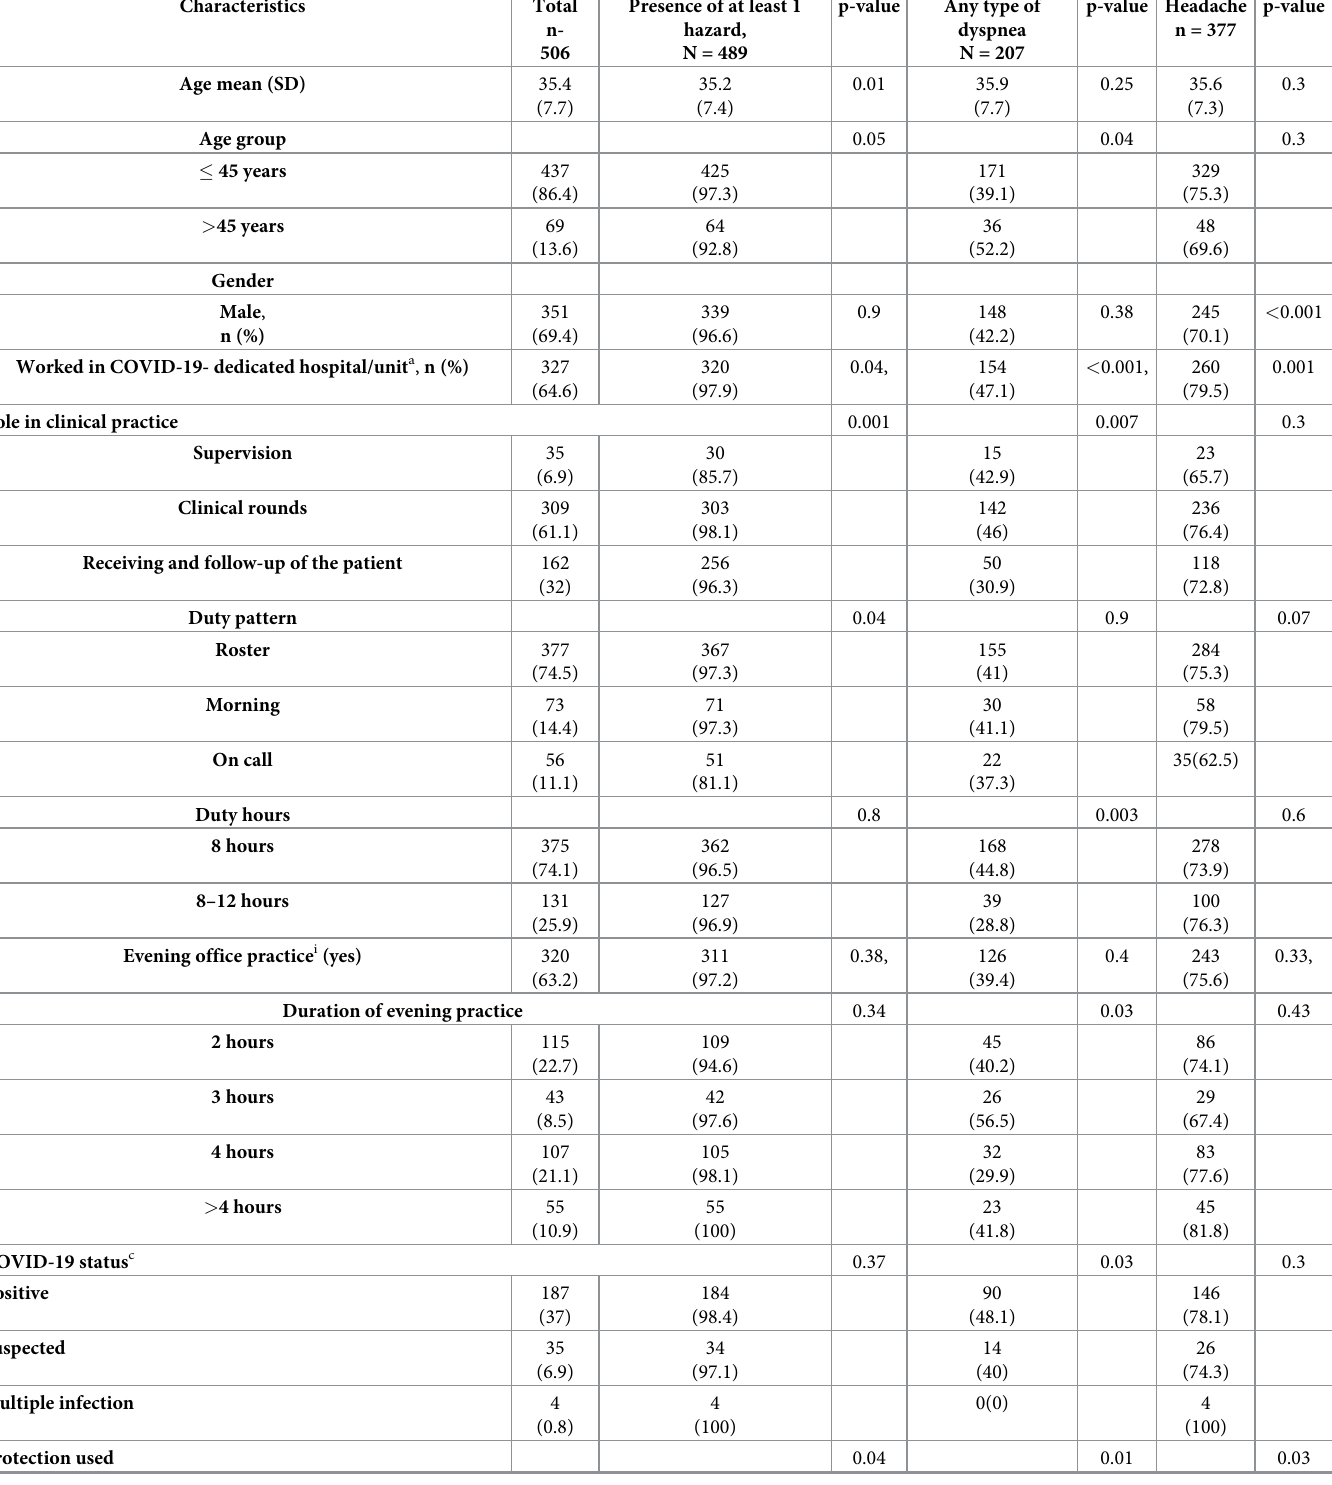
Table 1. Demography and distribution of different risk factors among the total population and the different